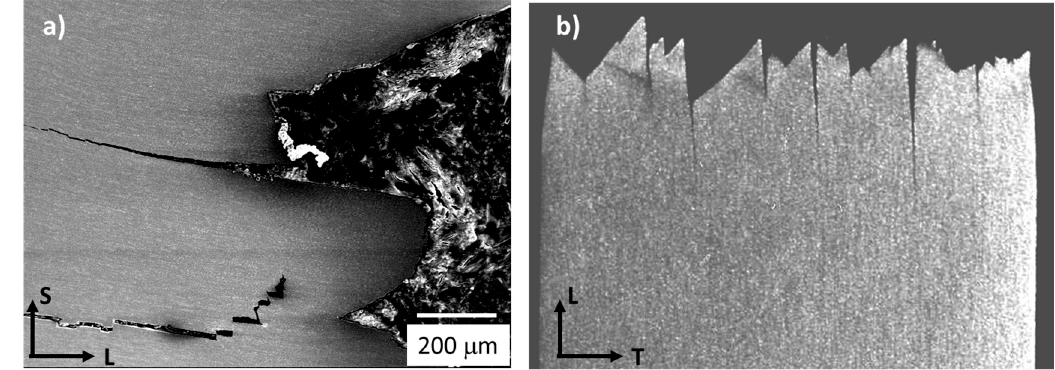
Figure 3. Charpy Impact energy of the PMT samples for LT and LS specimens. The arrows indicate Ductile-brittle transition temperature (DBTT) for LS and LT samples.